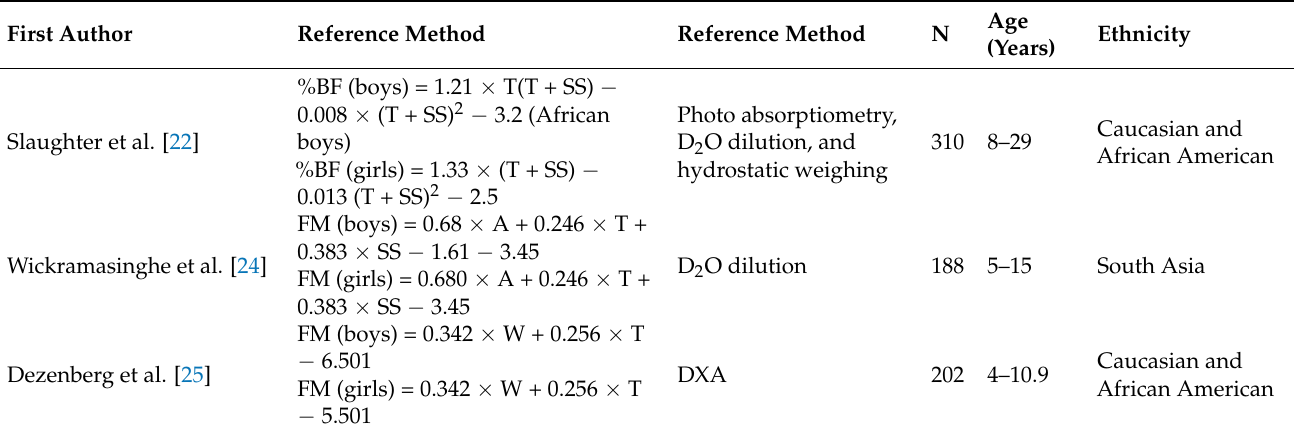
Table 1. Characteristics of skinfold-equation methods used for deriving body fat percentage in children derived from Wickramasinghe, Slaughter, and